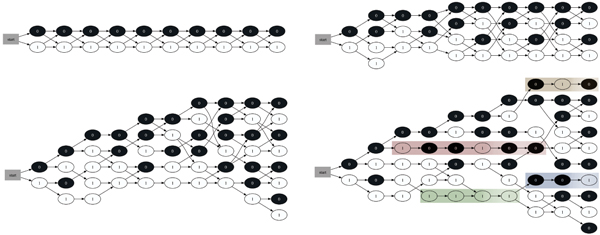
Visualization of the SpaMM structure learning algorithm. Sparse models λ1,...,λ4 of increasing order learned on the Daly dataset are shown. Black/white nodes encode more frequent/less frequent allele in population. Conserved fragments identified in λ4 are highlighted.